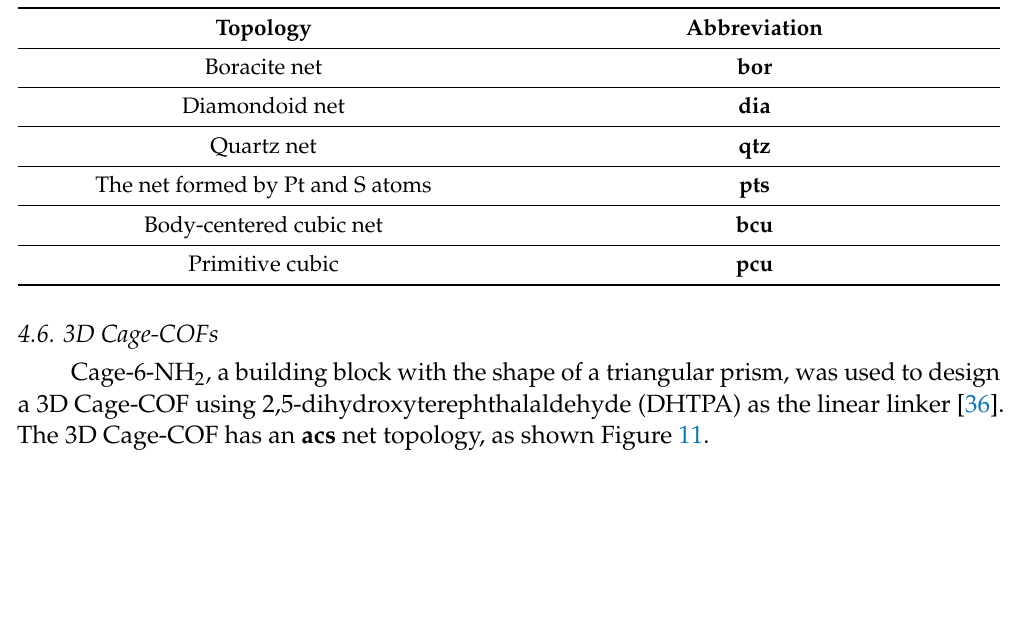
Figure 11. Synthesis of 3D Cage-COF [36].